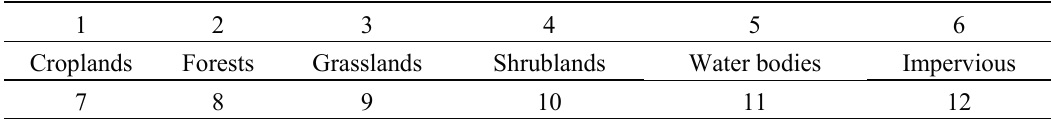
Table 2. Classification